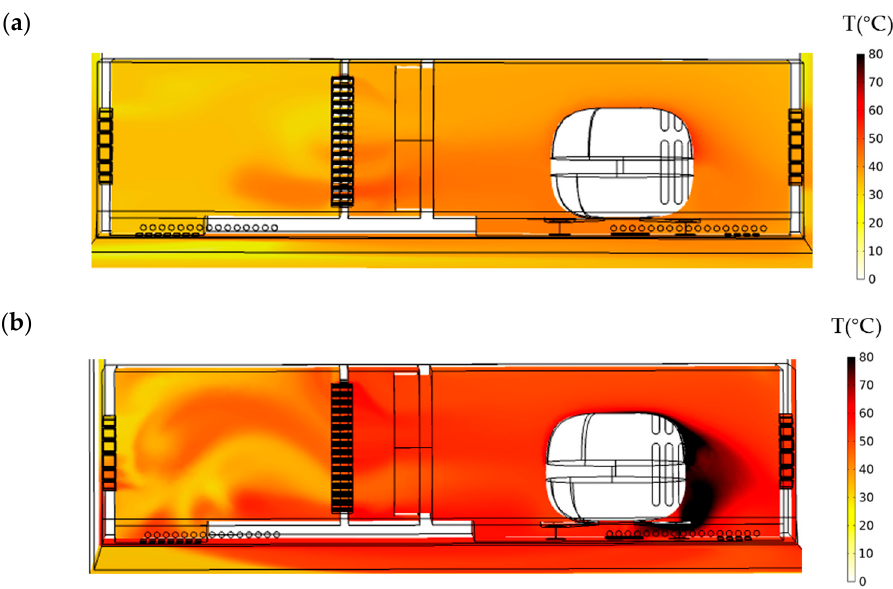
Figure 8. Temperature contours of condenser-compressor room for two configurations (°C): ( a ) free- standing and ( b ) built-in. Table 5. The temperature of positions in condenser-compressor room for two configurations.